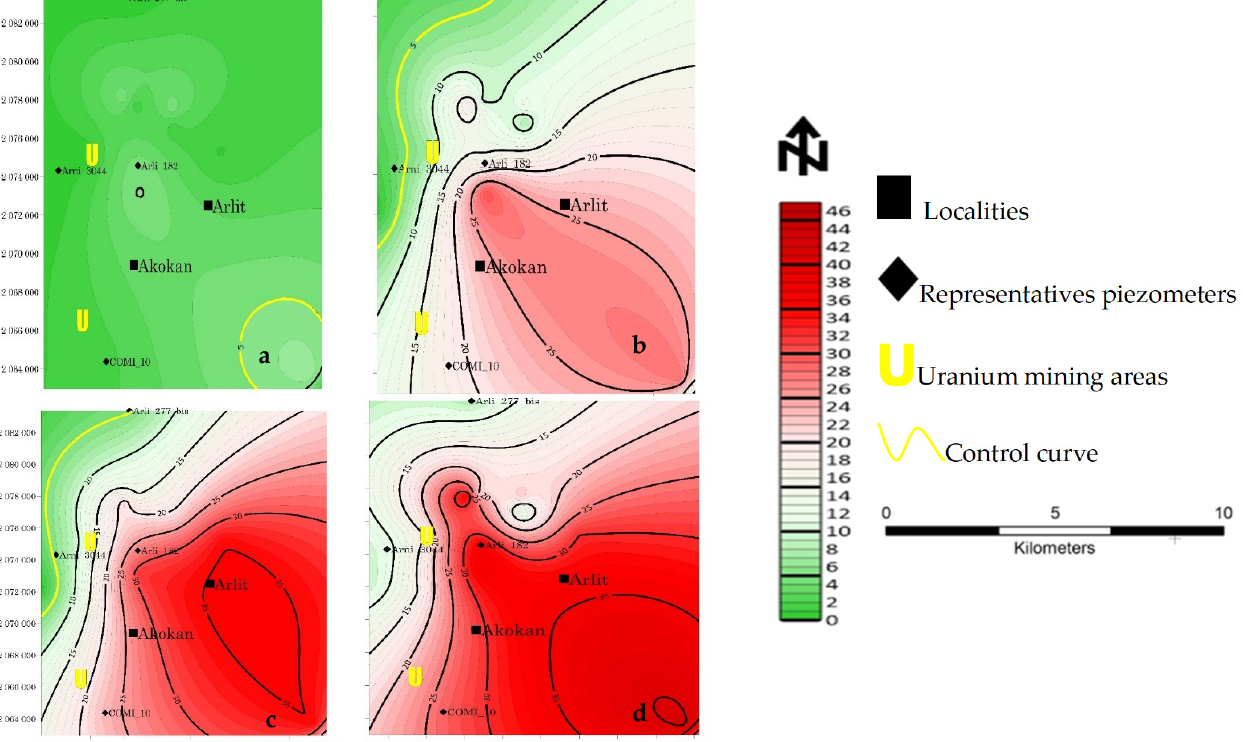
Figure 6. Spatiotemporal drawdown of Tarat water table from ( a ) 1977 to 1979, ( b ) 1977 to 1989, ( c ) 1977 to 1999, and ( d ) 1977 to 2009.